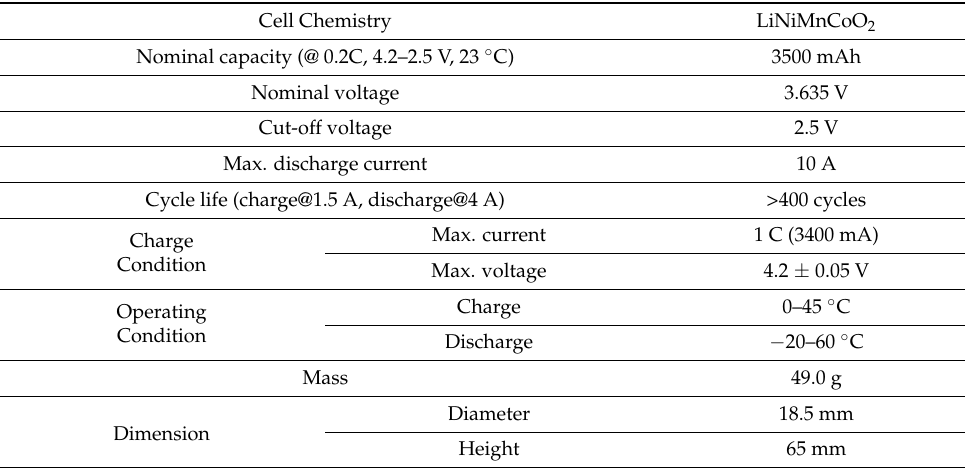
Figure 1. Architecture for SOH estimation using ANN-based classifier. The yellow signals are measurements from the cell. Table 1. Nominal characteristics of cylindrical LG 18650 MJ1 lithium-ion cell [37].